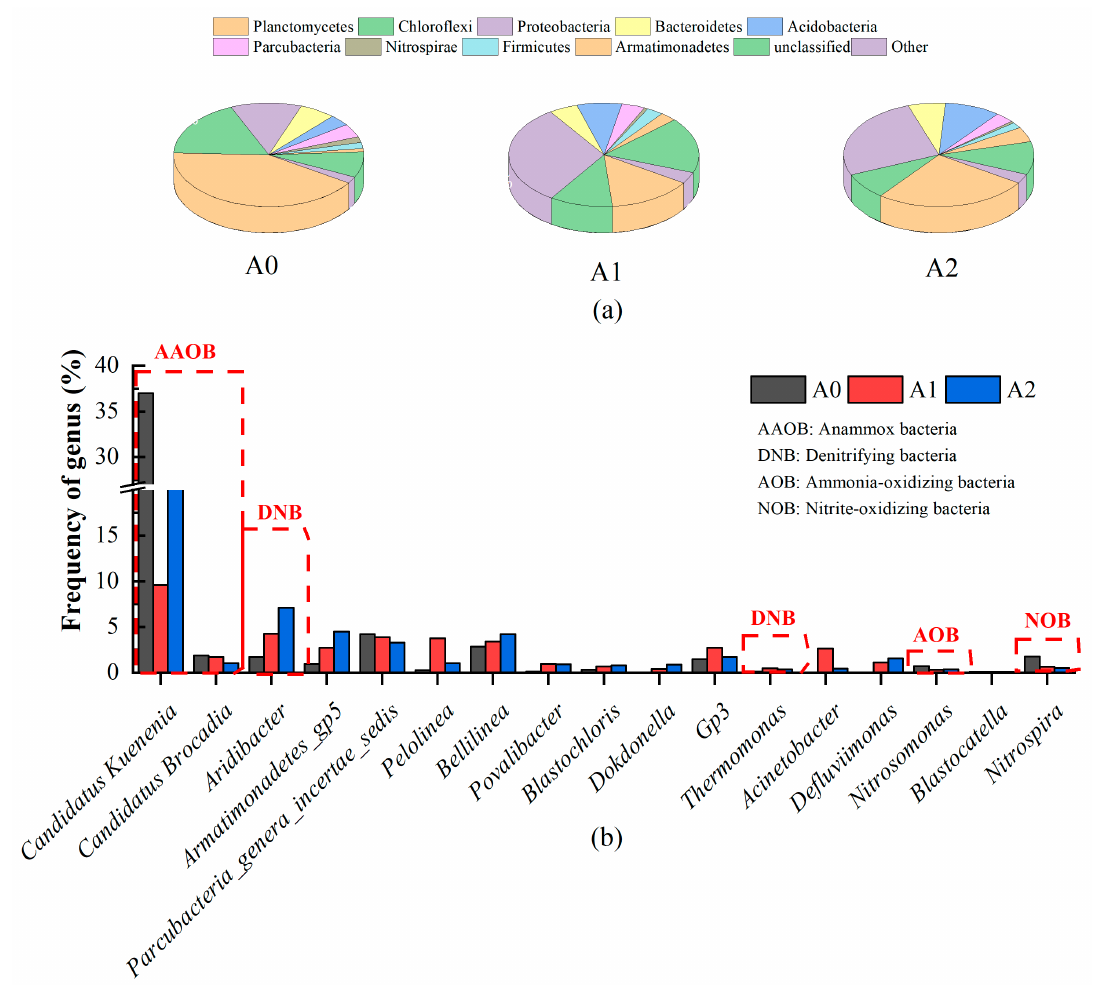
Figure 4. Relative abundance of microorganisms in the A1 and A2 immobilized fillers at the phylum